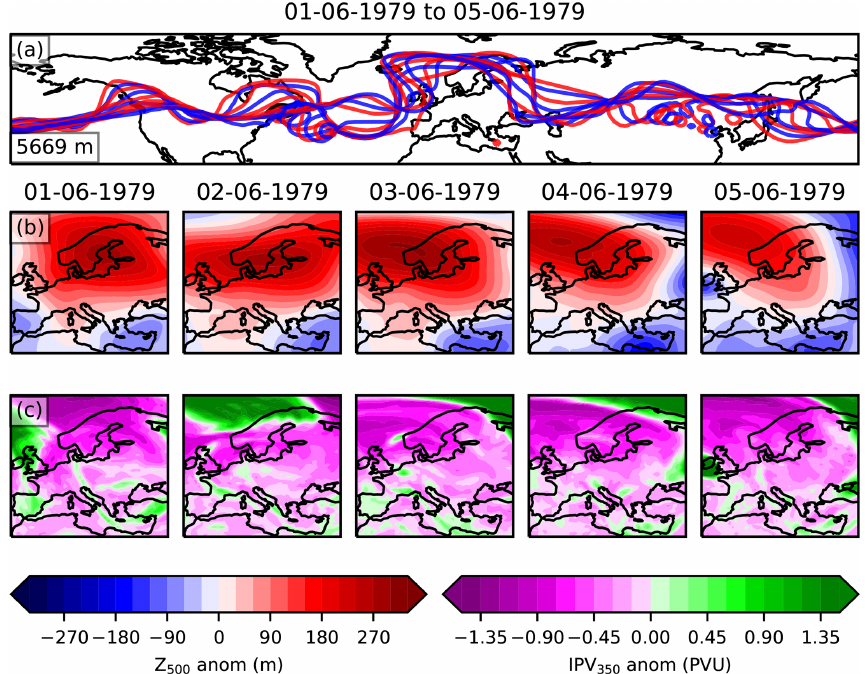
Figure 1. The information used to classify blocks in the ERA5 ground truth dataset (GTD). Panel (a) shows the Z 500 contour for the averaged value across 30–70 ◦ N, indicated in the bottom left of the panel. The red and blue colours highlight the contours at midnight and midday respectively. Panels (b) and (c) show the Z 500 time detrended anomaly and IPV 350 anomaly for each